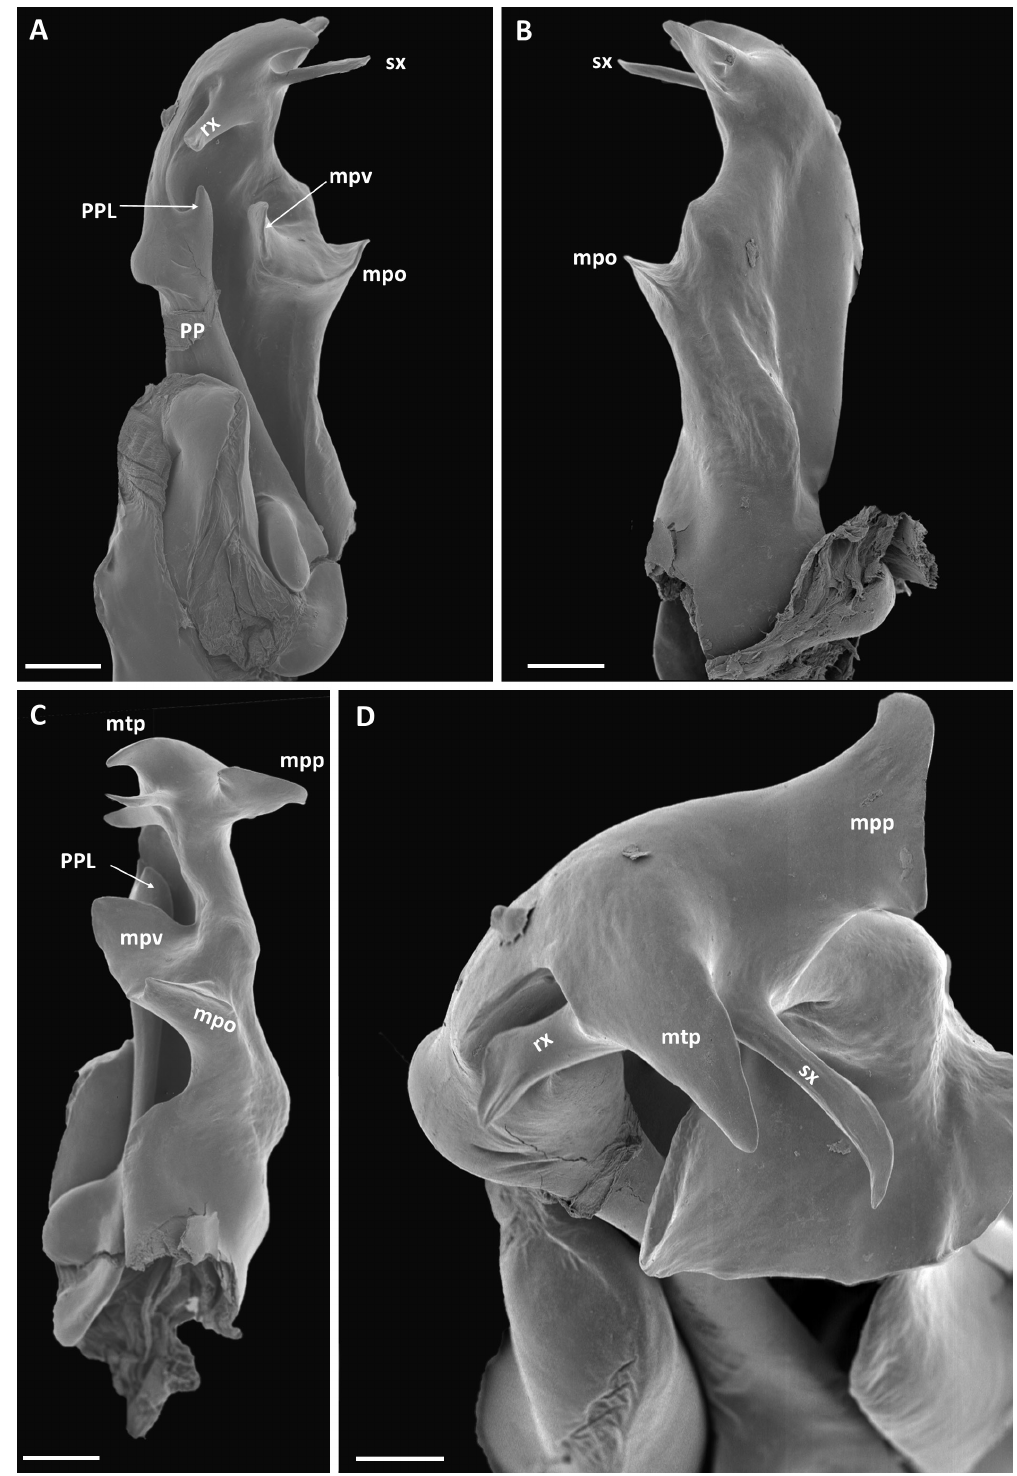
Fig. 63. Xystopyge bentemarieae sp. nov., holotype, ♂ (NHMD 621766), left gonopod coxa. A . Anterior view. B . Posterior view. C . Mesal view. D . Apical view. Abbreviations: MP = metaplica; mpo = metaplical ridged process; mpp = metaplical posterior process; mpv = metaplical vertical lobe; mtp = metaplical triangular process; PP = proplica; PPL = proplical lobe; rx = metaplical subrectangular process; sx =slender metaplical process. Scale bars: A–C = 0.2 mm; D = 0.1